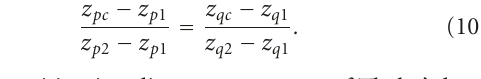
S ∈ p 1 p 2 falls out of x .